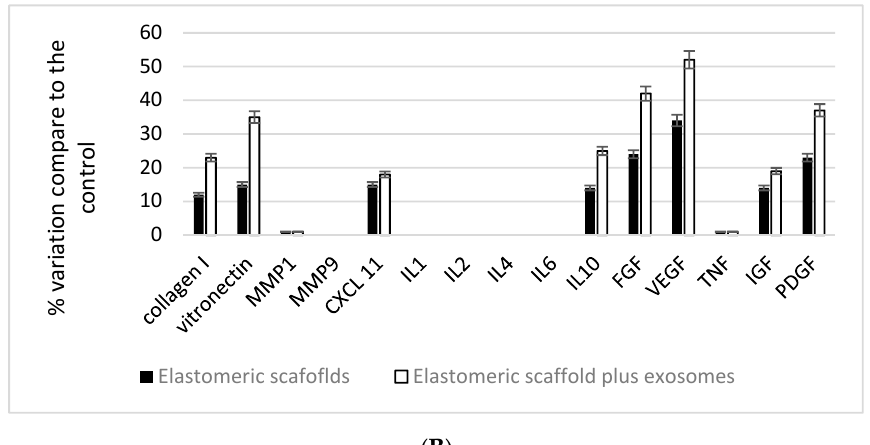
Figure 7. Graphical representation of: ( A ): heat map related to real-time PCR of the mRNA levels of MSC seeded onto elastomeric fibers (CTRL) and test conditions (elastomeric fibers plus exosomes) over 7 days of culturing. ( B ): protein evaluation of secretion product of MSC seeded onto elastomeric scaffolds and onto elastomeric scaffolds plus exosomes. Results are reported as a % of variation compared to the control (MSC cultured onto cell culture dishes surface).